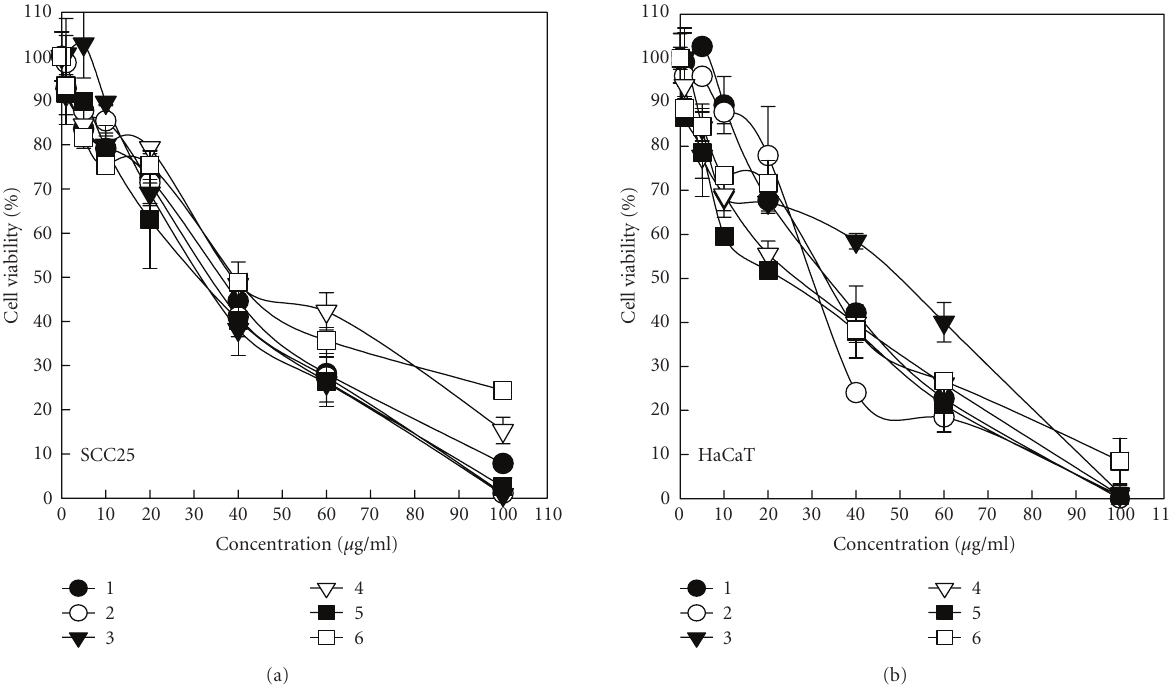
Figure 1: Dose-dependency e ff ects of the genus Sinularia extracts on the cell growth inhibition of SCC25 and HaCaT cells. Percentage of viable in cells treated with 0–100 μ g/mL concentrations of Sinularia extracts for 18 hours and determined by MTS assay. Data are means ± S.D. from three independent experiments. ( • ) S . grandilobata , 1; ( ◦ ) S . parva , 2; ( (cid:2) ) S . triangula , 3; ( (cid:3) ) S . scabra , 4; ( (cid:4) ) S . nanolobata , 5; and ( (cid:5) ) S . gibberosa , 6.